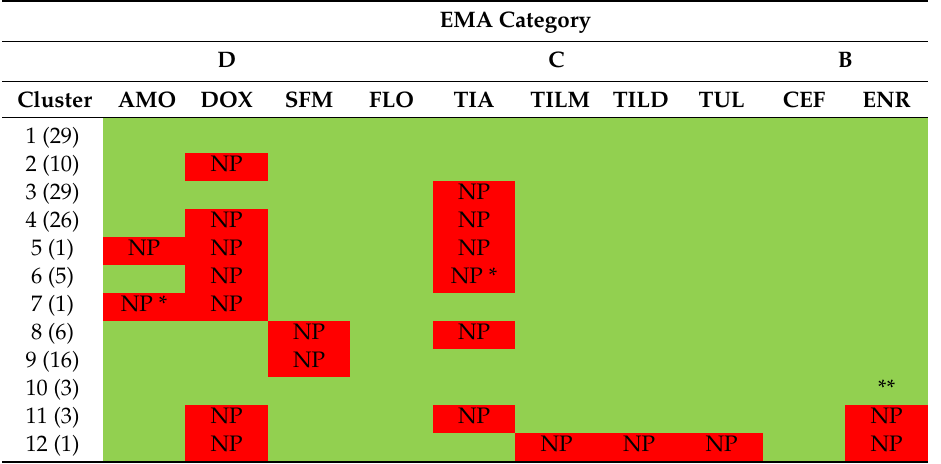
Table 2. Antimicrobial susceptibility pattern for the 12 clusters obtained from 130 Pasteurella multocida isolates after a hierarchical clustering analysis. It is detailed in brackets the number of strains belonging to each cluster. Suitable antimicrobials are detailed in green color. The antimicrobials tested included amoxicillin (AMO), ceftiofur (CEF), doxycycline (DOX), enrofloxacin (ENR), florfenicol (FLO), sulfamethoxazole / trimethoprim (SFM), tiamulin (TIA), tilmicosin (TILM), tildipirosin (TILD), and tulathromycin